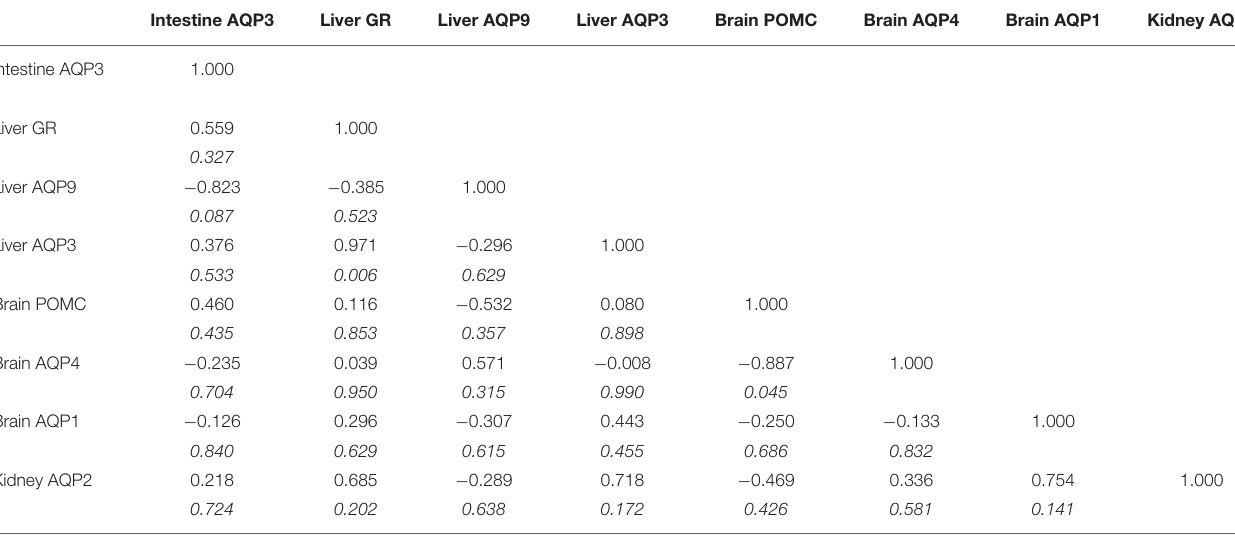
TABLE 6 | The correlation coefficient (r) between different mRNA transcripts means on Day-5 1,2 . Intestine AQP3 Liver